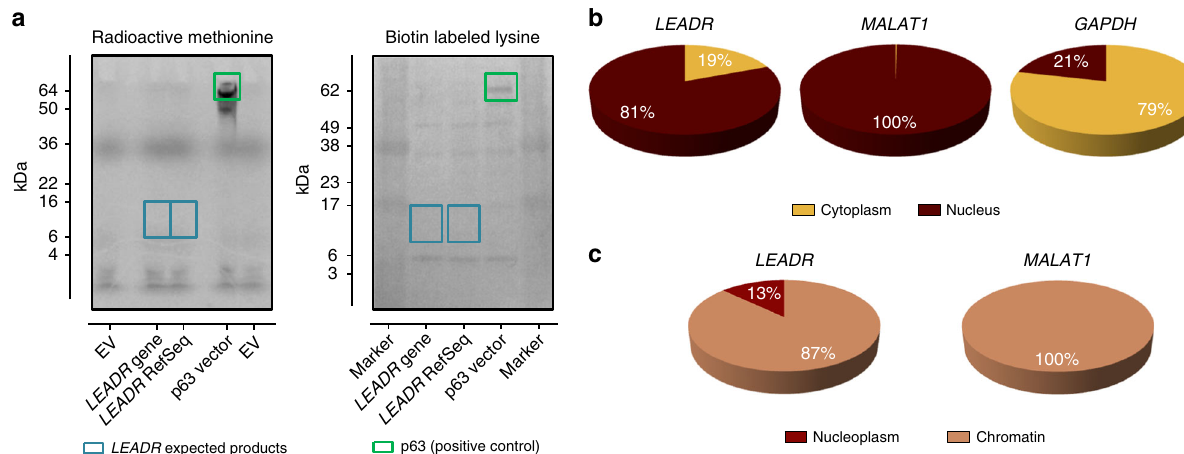
Fig. 4 LEADR is a nuclear chromatin-associated long intergenic noncoding RNA. a Polyacrylamide gel electrophoresis of in vitro transcription/translation assay conducted using alternatively [ 35 S]-methionine ( left ) or biotinylated lysine ( right ) as detection systems. Vectors containing either the whole genomic sequence ( “ gene ” ) or RefSeq transcript were used to assess protein production by LEADR . No protein products at the predicted molecular weight between 5 and 16 kDa (as indicated by the turquoise rectangle) were observed. Vector expressing p63 was used as positive control (in vitro translated p63 protein indicated by the green rectangle). b Pie charts of relative abundance of LEADR , MALAT1 (nuclear control), and GAPDH (cytoplasmic control) transcripts in the nuclear and cytoplasmic fraction of RWPE-1 cells, as assessed by qRT-PCR. Mean percentage from three independent experiments is plotted. c Pie charts of subnuclear distribution (chromatin or nucleoplasm) of LEADR and MALAT1 transcripts in RWPE-1 cells. Mean percentage from three independent experiments is plotted. Source data are provided as a Source Data fi le, together with n of all